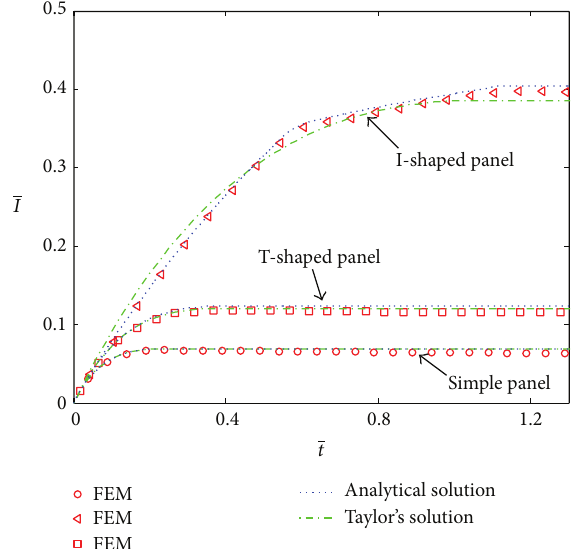
Figure 15: The analytical solutions and FE predictions of the nondimensional impulse for (a) simple panel; (b) the panel with stiffener (T-shaped); (c) the panel with girder